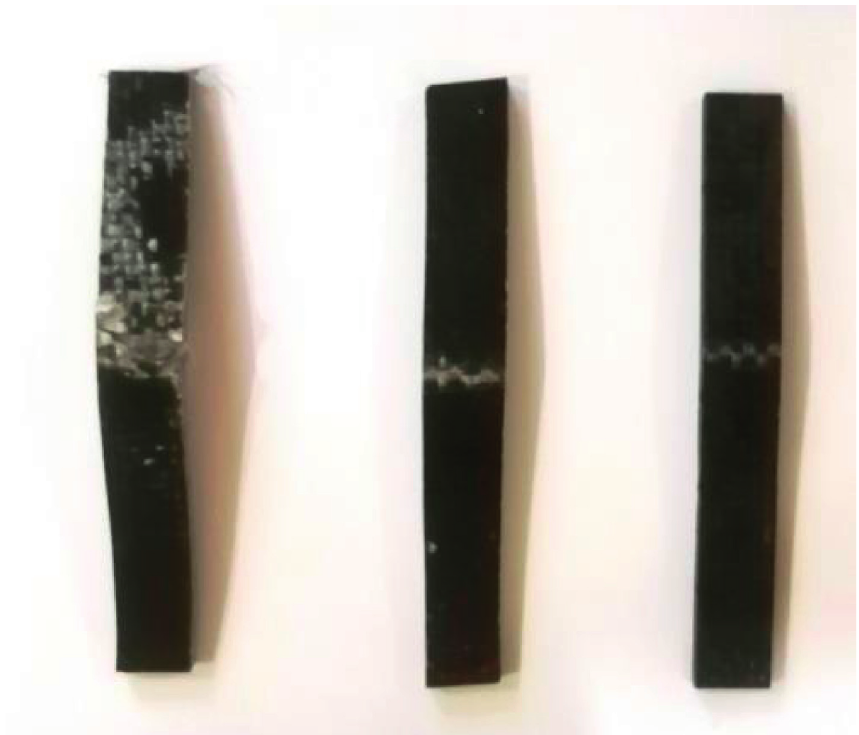
Figure 9: Representations of flexural tested samples for (a) L 1 laminate; (b) L 2 laminate; (c) L 3 laminate.